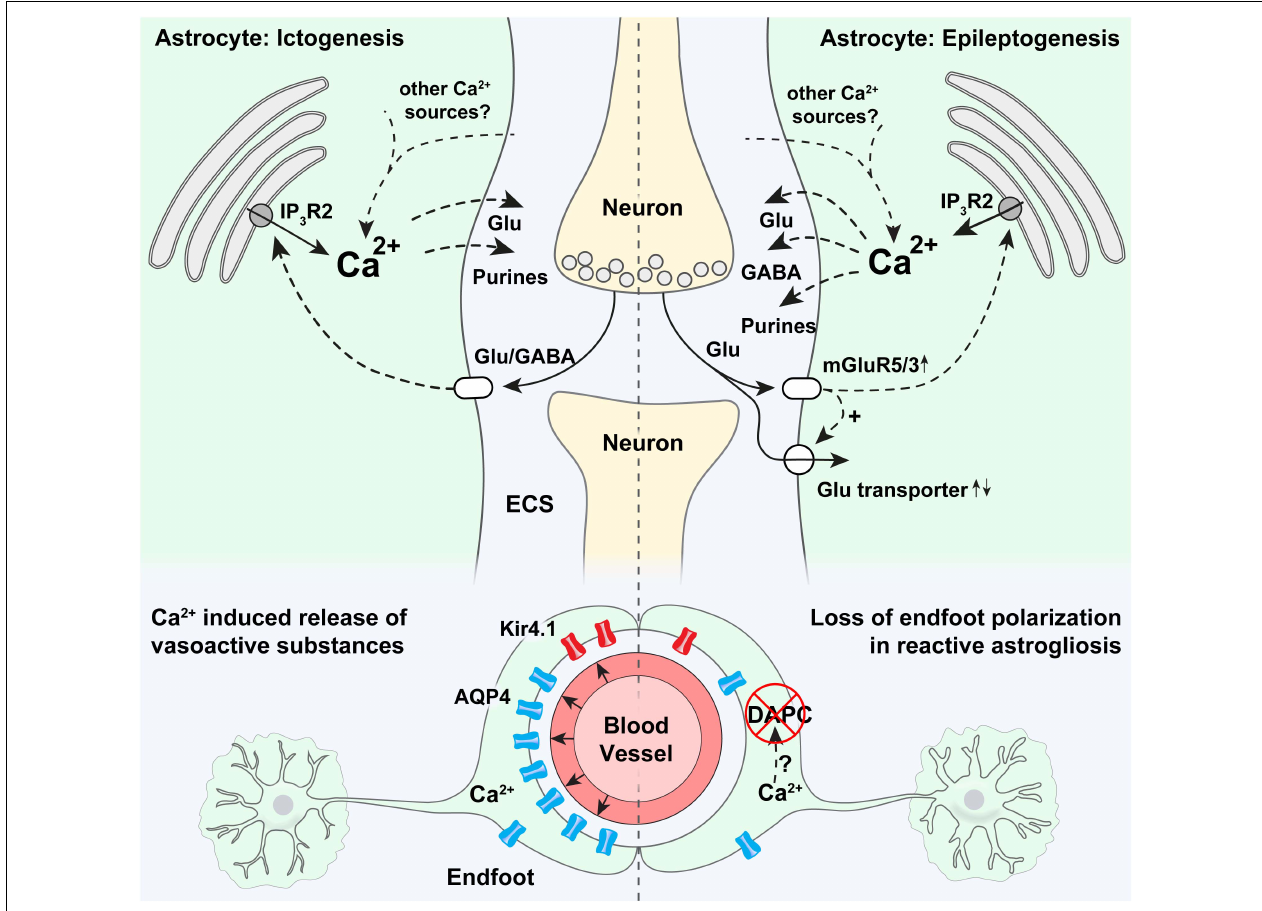
FIGURE 1 | Potential roles of astrocytic Ca 2 + signaling in epilepsy. Strong astrocytic Ca 2 + signals have been shown to occur in the emergency of acute seizures (in ictogenesis), that are probably triggered by neurotransmitters released by neurons. Ca 2 + increases at the onset of seizures are known to be partly mediated by release through IP 3 R2 from the endoplasmic reticulum, even though pronounced Ca 2 + signaling is present also in mice devoid of IP 3 R2. It is thought that intracellular Ca 2 + increases may trigger proconvulsive gliotransmitter release. In astrocytic endfeet, increased Ca 2 + signaling has been shown to correlate with ictal vasodilation. Epileptogenesis triggers a pronounced increase in mGluR5 expression, mGluR5-mediated Ca 2 + signaling, and increased glutamate uptake. An increase in astrocytic Ca 2 + signaling has been demonstrated in the days after status epilepticus, and aberrant Ca 2 + signaling at later time points in the epileptogenesis has been anecdotally reported. Increased Ca 2 + signaling could potentially cause both the release of glutamate (pro-convulsive), purines (pro-convulsive), and GABA (anti-convulsive, through Bestrophin-1 channels). In astrocytic endfeet in epileptic tissue a pronounced loss of aquaporin-4 (AQP4) and the K + inwardly rectifying channel Kir4.1 can potentially be due to Ca 2 + activated proteases causing a disassembly of the dystrophin associated protein complex (DAPC) tethering AQP4 and Kir4.1 to perivascular